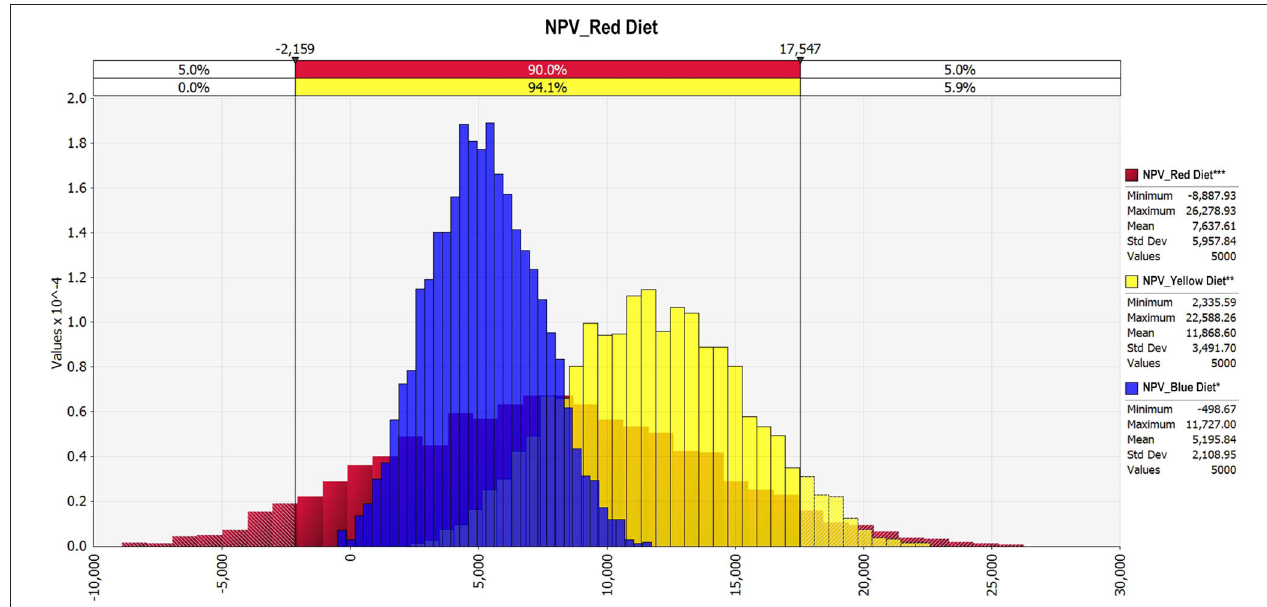
FIGURE 2 | Probability density of the NPV per evaluated diet. *100% Kikuyu grass, **35% Altoandina silage and 65% Kikuyu grass, ***65% Altoandina silage and 35% Kikuyu